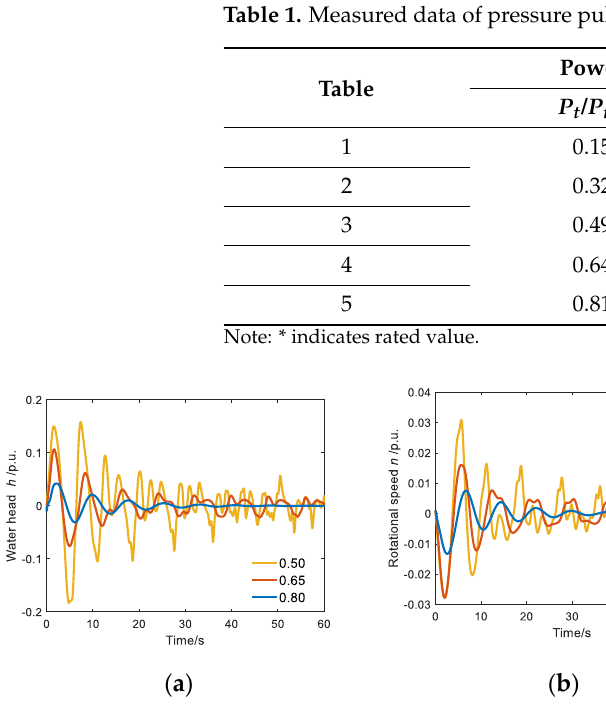
Figure 6. Time domain diagram of dynamic characteristics of HGS with different working conditions (0.5, 0.65, 0.8); ( a ) time domain diagram of relative deviation of water head h ; ( b ) time domain diagram of relative deviation of rotation speed n ; and ( c ) time domain diagram of relative value of power P t . Table 1. Measured data of pressure pulsation in the draft tube of a unit with different loads. Power Table